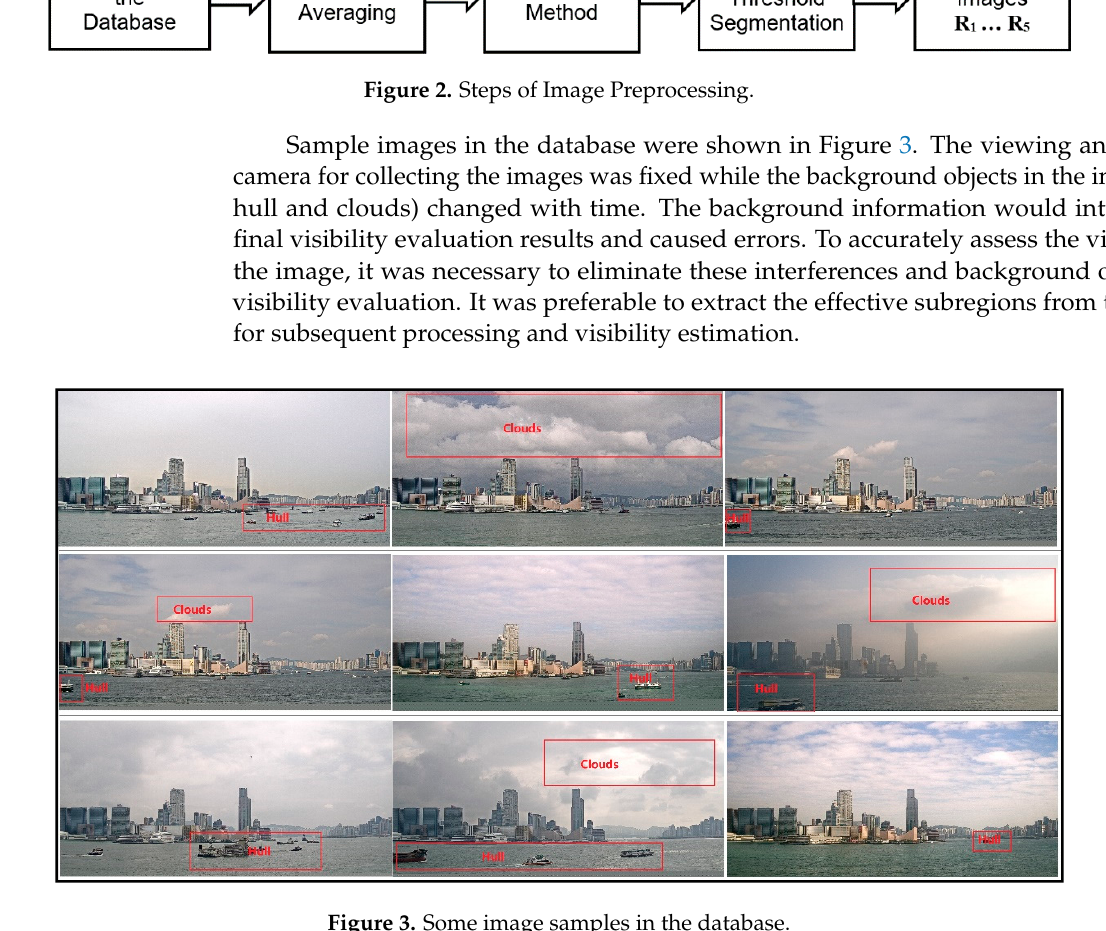
6 of 20 Figure 1. Flow Chart of Comprehensive Visibility Evaluation. 2.2.1. Image Preprocessing Due to the interference from the moving objects such as hull and the clouds in the sky during the process of digital image collection with fixed viewing angle, the moving objects will change their shapes and positions in the images. Therefore, these images need